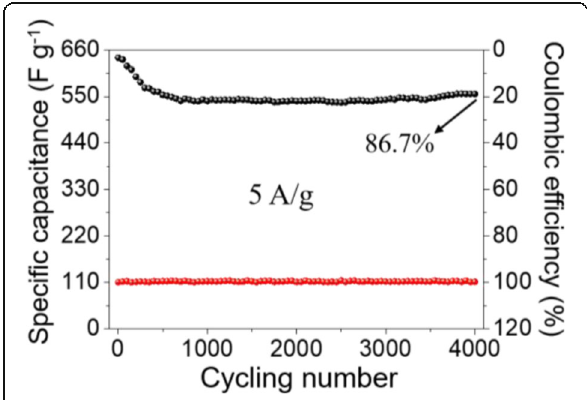
Fig. 7 Cyclic stability and Coulombic efficiency of the porous Co 3 O 4 cubes electrodes measured at 5 A g − 1